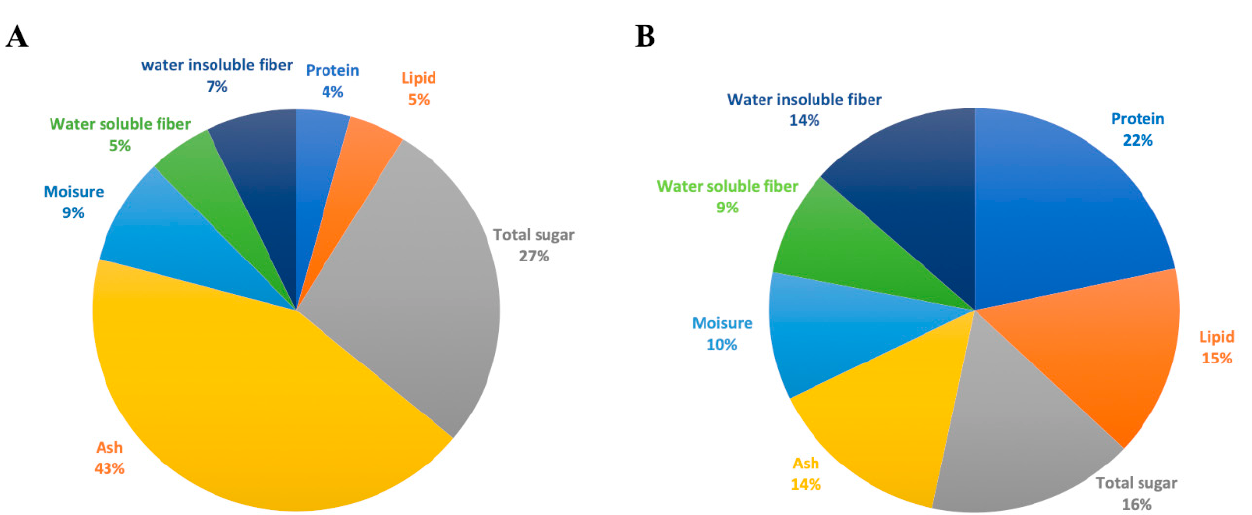
Figure 1. The nutritional composition of the fermented rakkyo. ( A ) The proportions of nutritional ingredients of the solution of fermented rakkyo residual powder. ( B ) The proportions of nutritional ingredients of fermented rakkyo residual liquid without adding dextrin sugar.